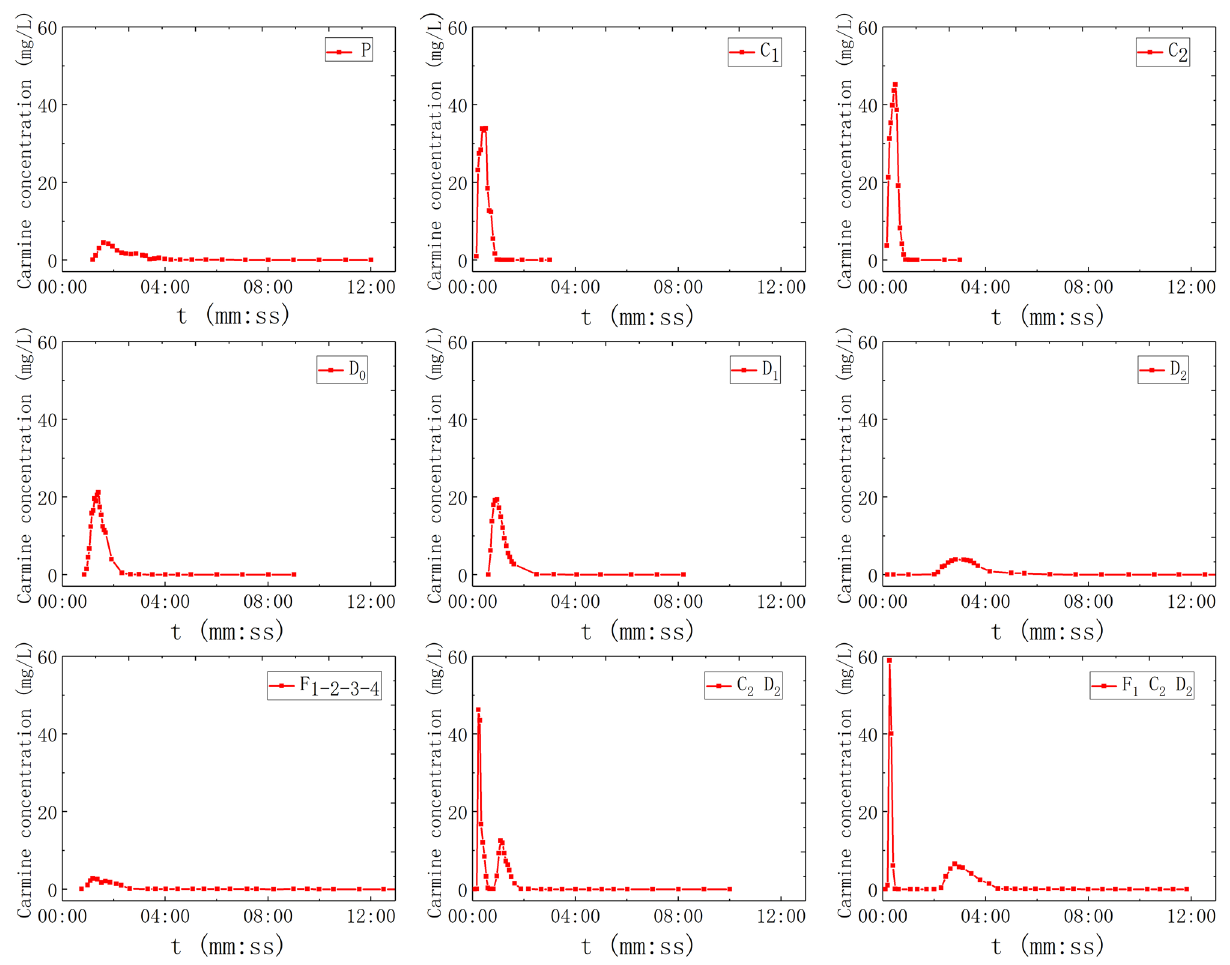
Figure 4. The BTC of solute transport under water-filling of fissure–conduit condition.